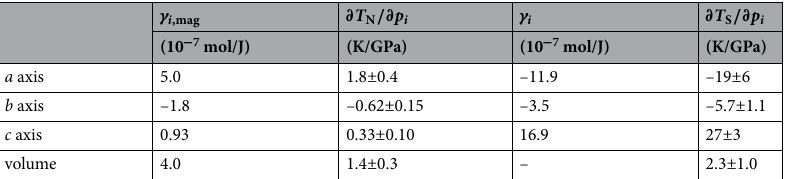
Table 1. Pressure dependencies of the transition temperatures calculated from the magnetic Grüneisen ratios γ i ,mag at T N , as well as from the jumps �α i and (cid:31) c p at T S , for the three main crystallographic axes. The hydrostatic pressure dependence dT S / dp is calculated as the sum of all three uniaxial ones and denoted as